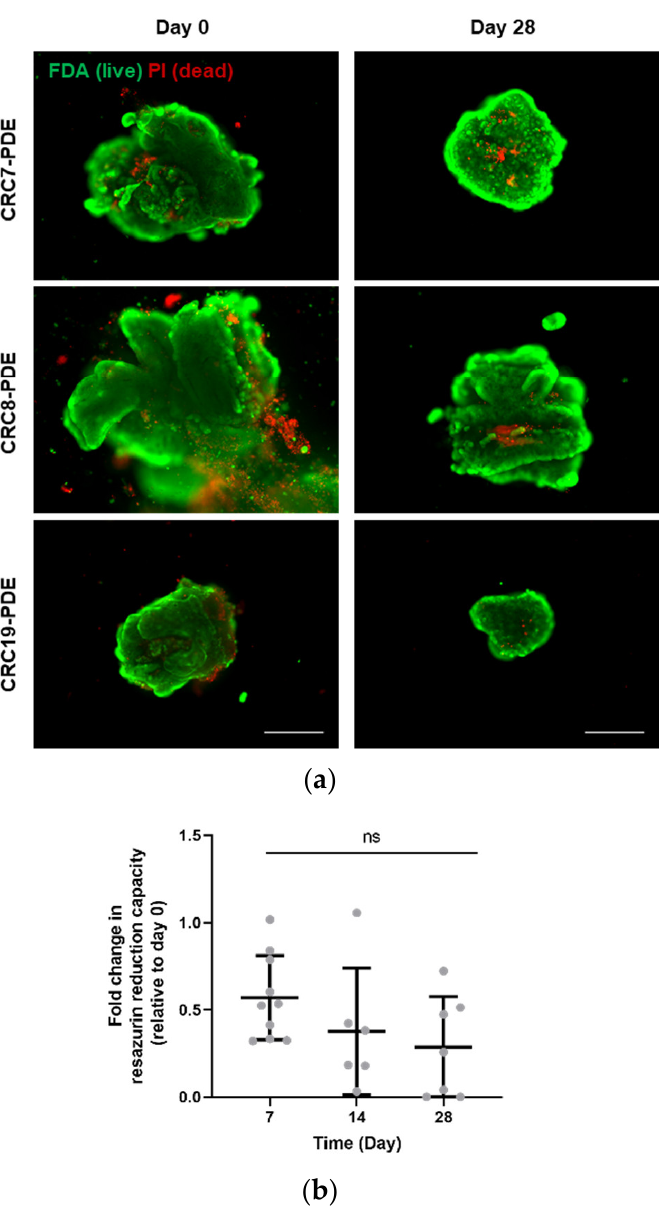
Figure 2. CRC-PDE culture cell viability. ( a ) Representative images of CRC-PDE culture at day 0 (immediately after processing of the tumour tissue) and after 4 weeks, stained with fluorescein diacetate (FDA, green) and Propidium Iodide (PI, red) for detection of live and dead cells, respectively. Scale bar: 500 µ m. ( b ) Measurement of resazurin reduction capacity of the CRC-PDE cultures along time. Data are presented as the mean of fold change relatively to day 0 ± SD, calculated from 10 biological replicates. Statistical significance was evaluated by a mixed effects model for analysis of repeated measurements followed by a post-hoc Tukey’s multicomparison test. CRC-PDE, colorectal cancer patient-derived explants; ns,